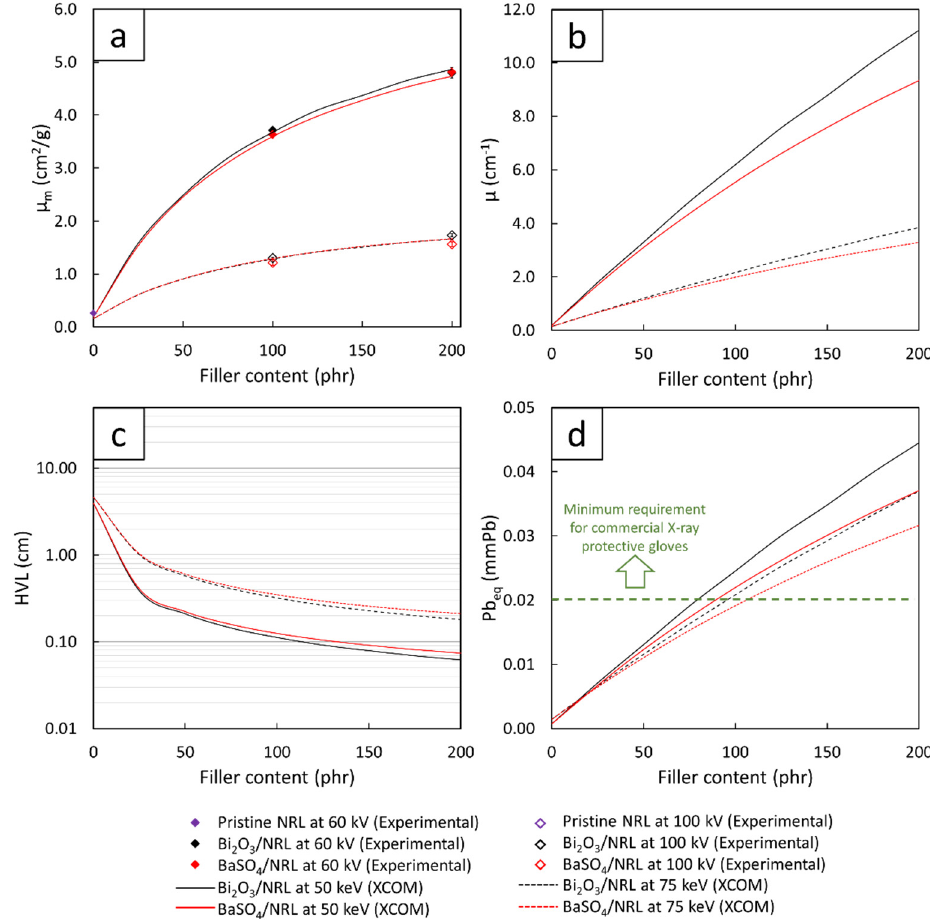
Figure 6. ( a ) Mass attenuation coefficients ( µ m ), ( b ) linear attenuation coefficients ( µ ), ( c ) half value layer (HVL), and ( d ) lead equivalence (Pb eq ) of Bi 2 O 3 /SVNRL and BaSO 4 /SVNRL composites containing varying filler content from 0 to 200 phr. The dotted line in ( d ) represents the minimum requirement for commercial X-ray protective gloves.